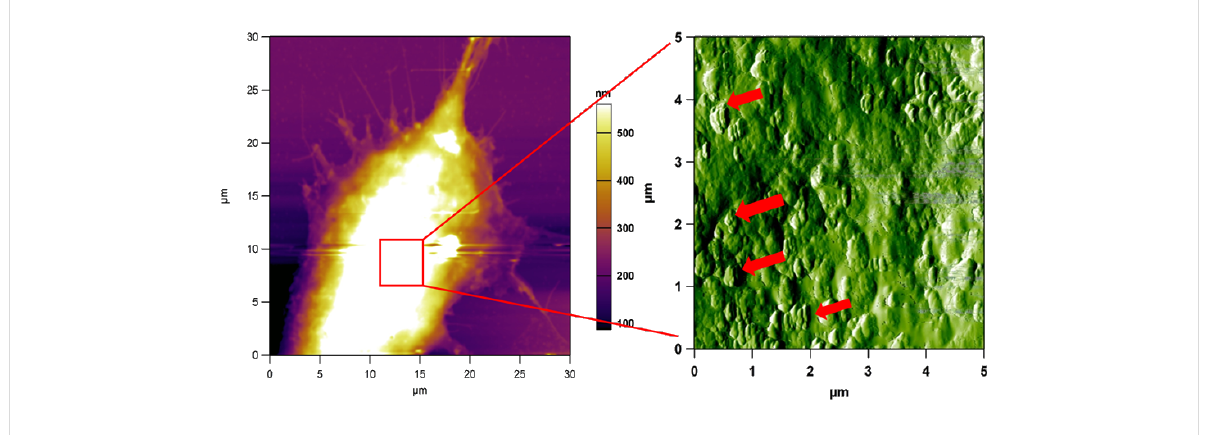
Figure 7: (a) AFM height image of a large fibroblast in vitro and incubated with diluted tattoo ink (1:10,000), followed by chemical fixation. (b) Phase image (5 μ m) of the highest part of the cell body, which shows many regions (red arrows) of clumped ink particles on the cell surface.